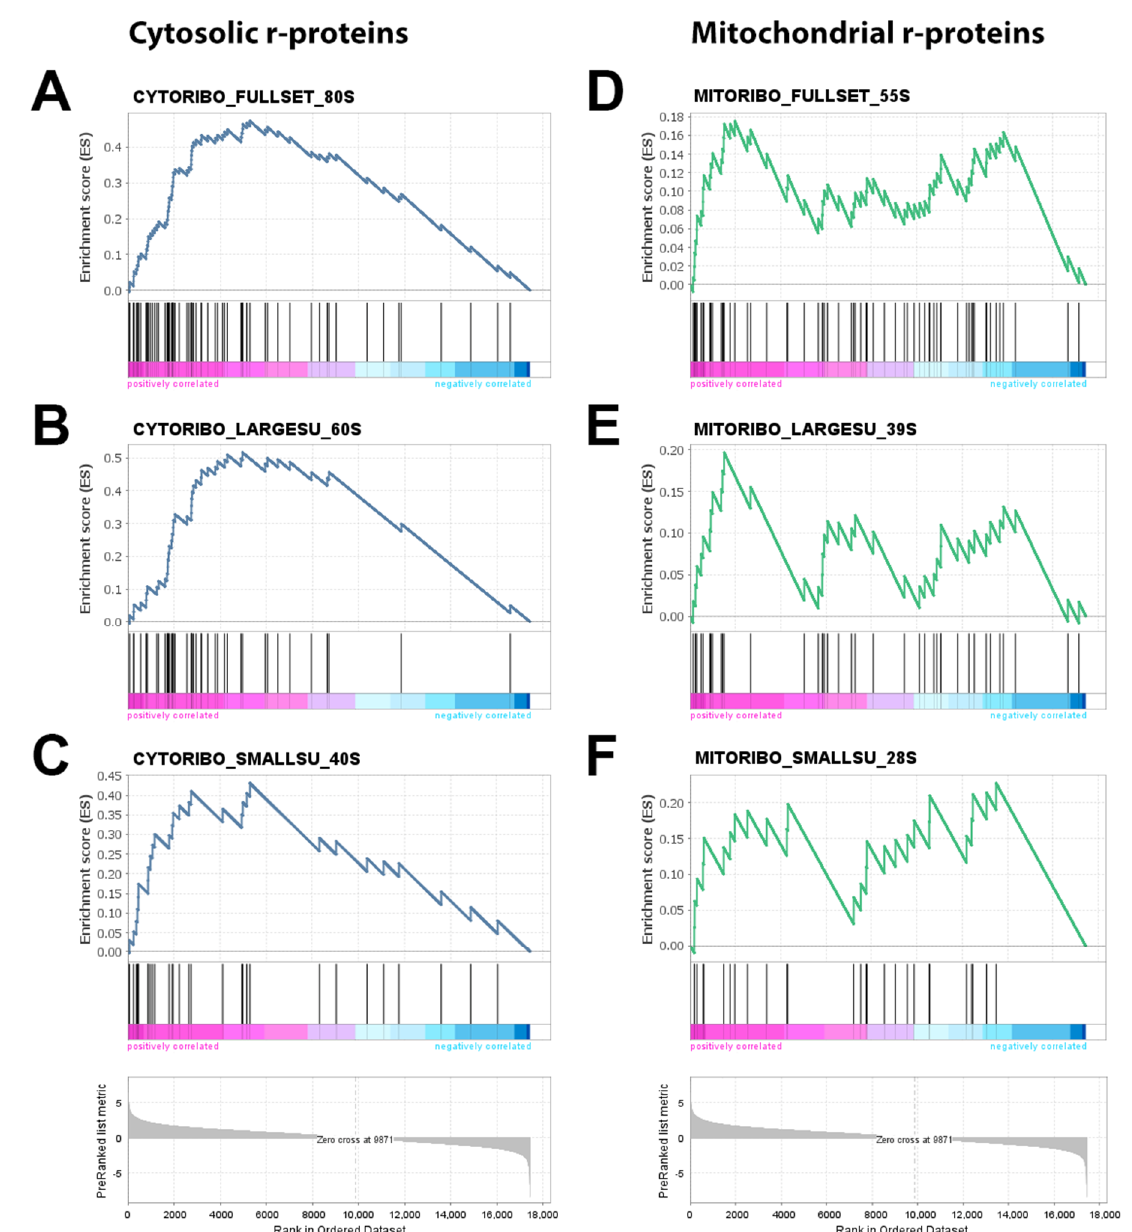
Figure 3. Gene set enrichment analysis of the ribosomal protein gene set. For each gene, a paired t -test was computed and the resulting t-value was used as a ranking metric (bottom grey plots). Black bars over the magenta-cyan scales in each subplot indicate the position of each RPGS gene along the ranked gene list. ( A – C ) Cytosolic rProtein transcripts were significantly enriched ( q -value < 10 − 3 ), whereby genes tended to gather consistently towards the positive edge of the ranked gene list. ( D , E ) In contrast, mitochondrial rProtein genes were much more evenly distributed across the ordered dataset.